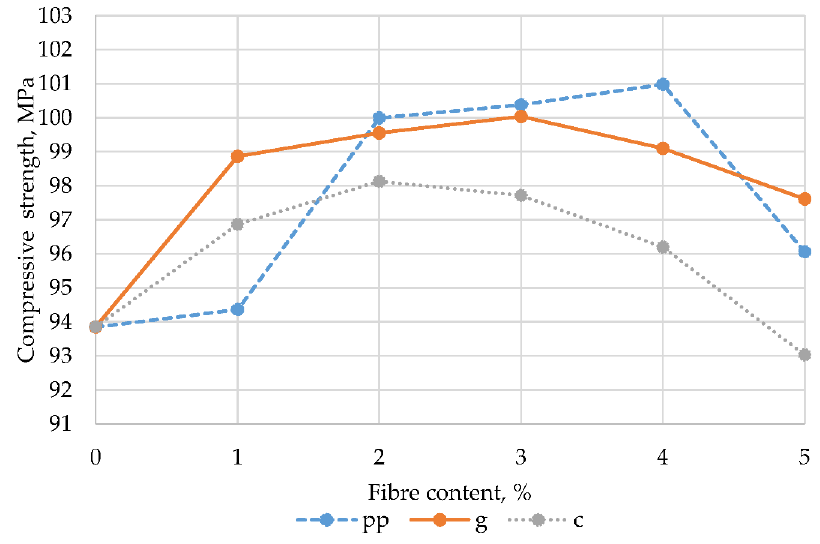
Figure 9. Dependence of compressive strength on the content and type of fibres.